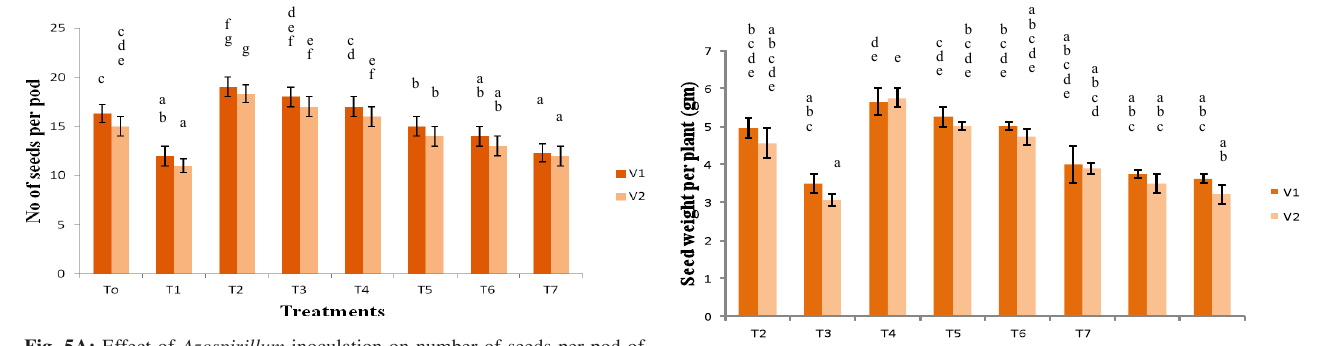
Fig. 5A: Effect of Azospirillum inoculation on number of seeds per pod of two canola varieties (v1 and v2) grown under drought stress. Where, To = Un-inoculated and well watered, T = Un-inoculated and drought exposed, T2 = Seed inoculated and well watered, T3 = Rhizosphere inoculated and well watered, T4 = Seed inoculated with heat killed inoculums and well watered, T5 = Seed inoculated and drought exposed, T6 = Rhizosphere inoculated and drought ex- posed, T7 = Seed inoculated with heat killed inoculums and drought exposed. And V1 = Rainbow, V2 = Con II.